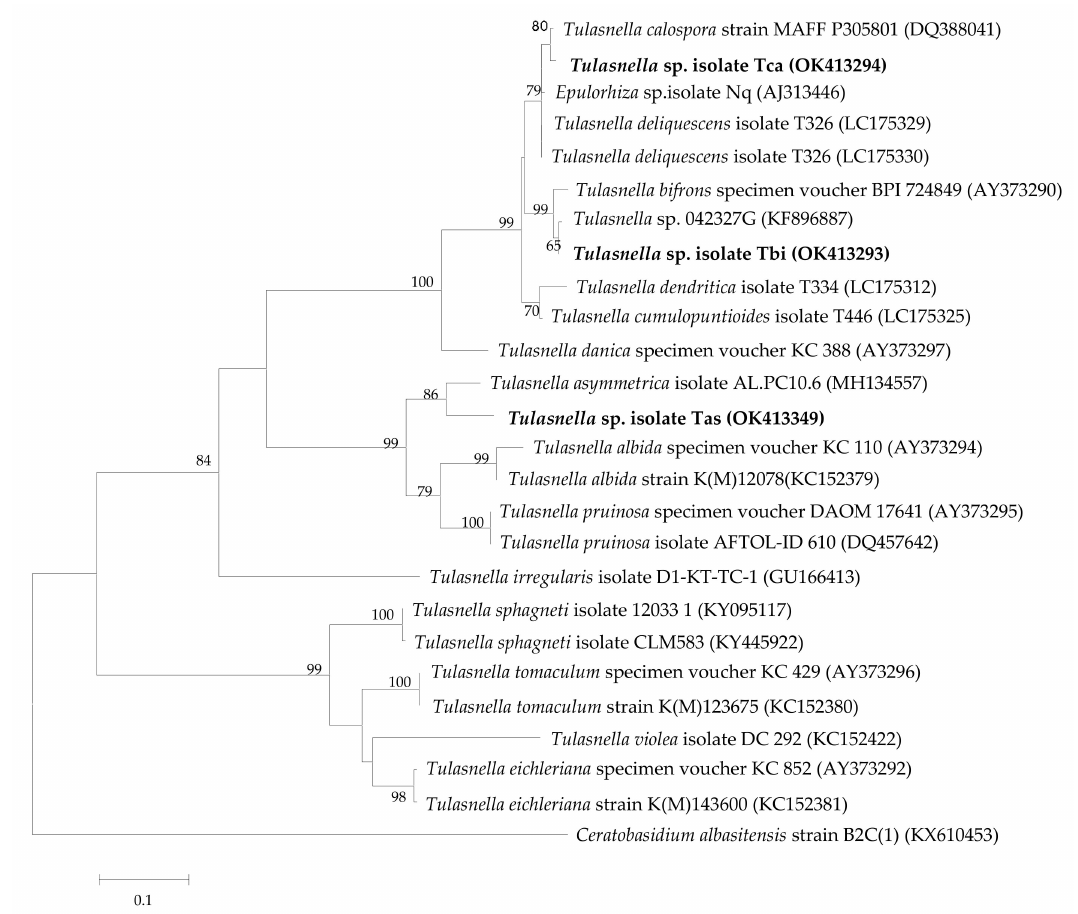
Figure 3. Maximum likelihood trees of ITS sequences of Tulasnella spp. The sequence of Ceratobasidium albasitensis strain B2C (1) was used as an outgroup. Bootstrap percentages (based on 1000 replications) >50% are shown at the branching points. Scale, 0.1 nt substitutions per